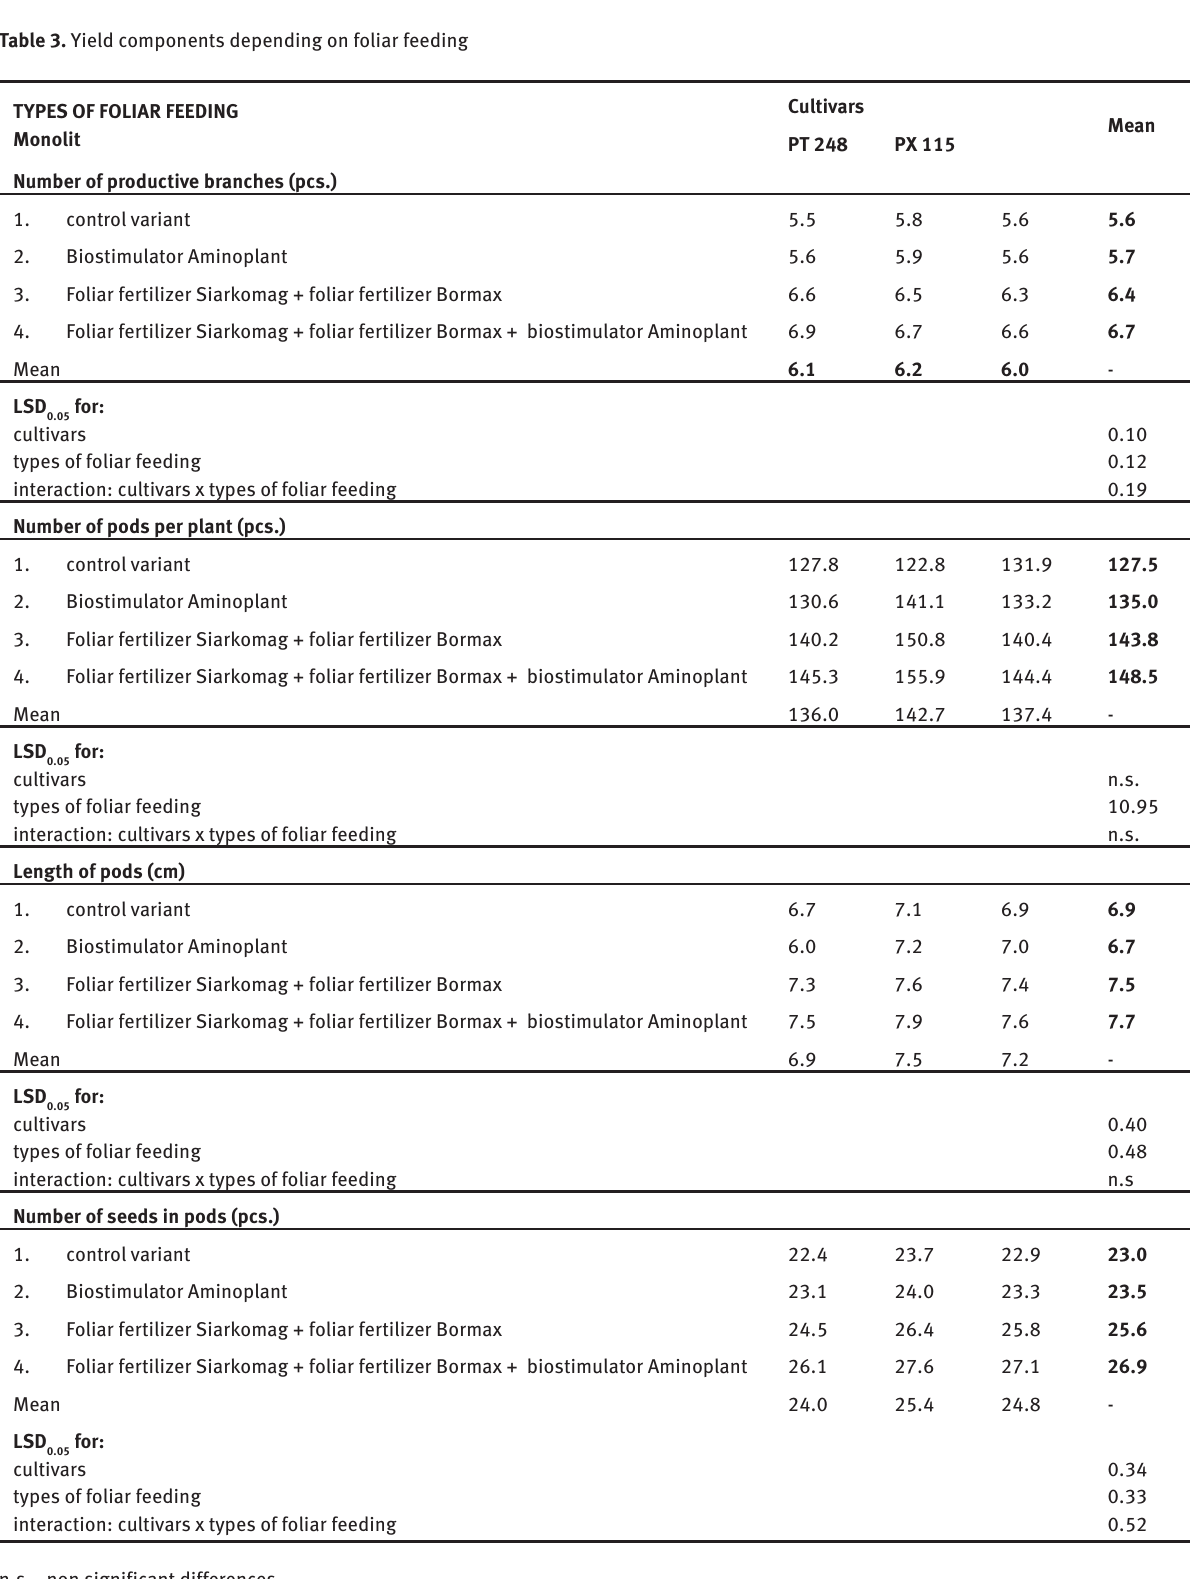
Table 3. Yield components depending on foliar feeding TYPES OF FOLIAR FEEDING Monolit Number of productive branches